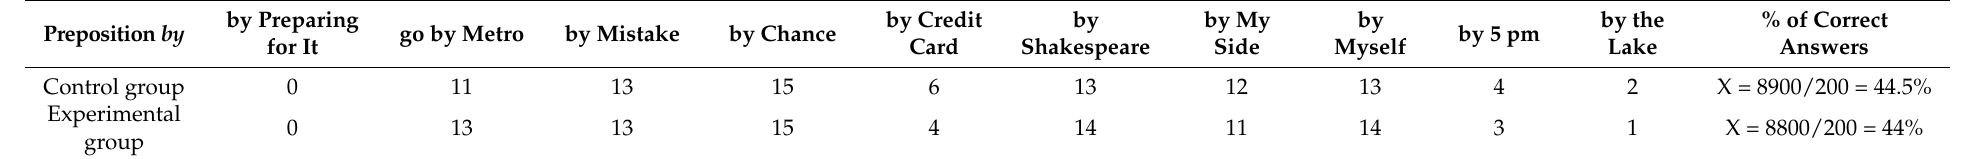
Table 5. Pretest of the preposition by